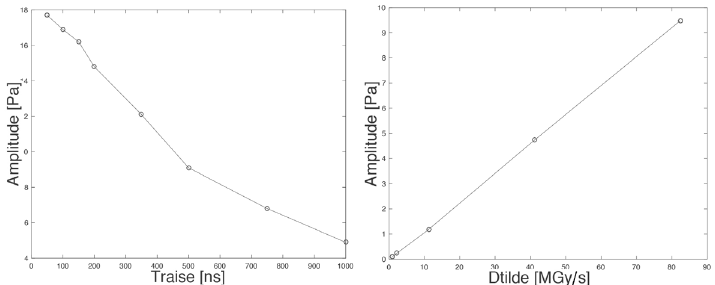
Figure 2. Acoustic signal amplitude vs Rising Time (Left) and vs Deposited Dose per unit time (Right)